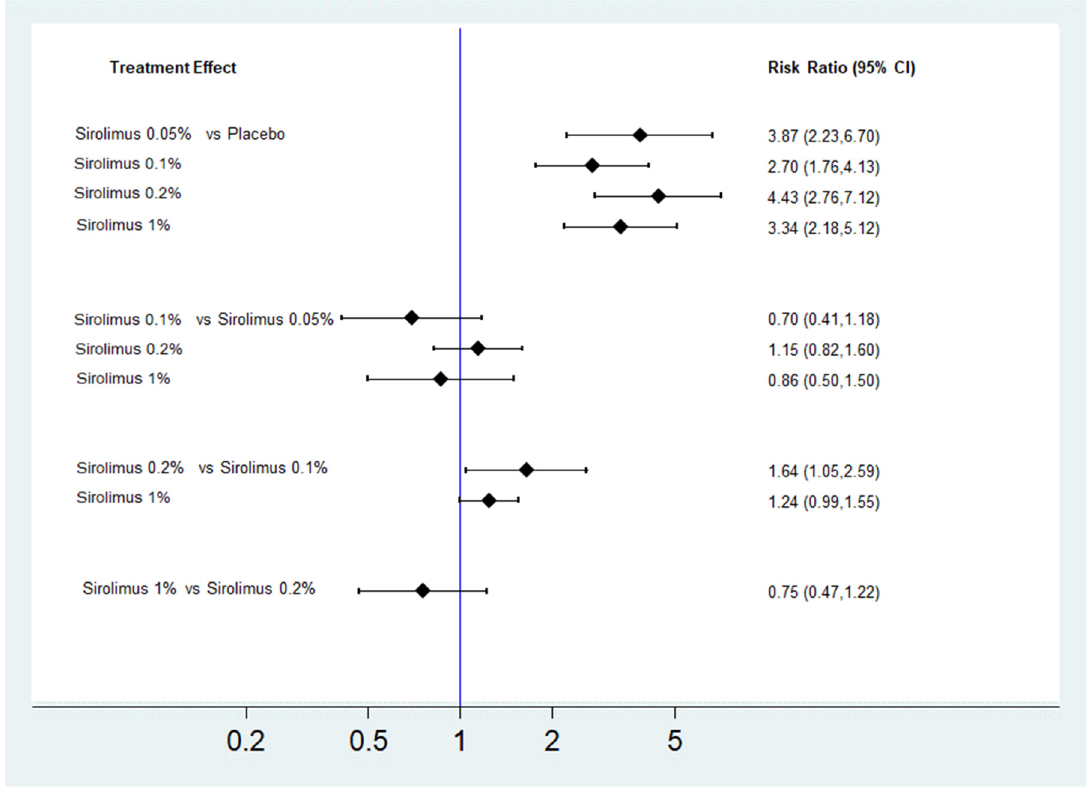
Figure 3. Forest plots of network meta-analysis of treatments for facial angiofibromas: analysis based on clinical improvement.